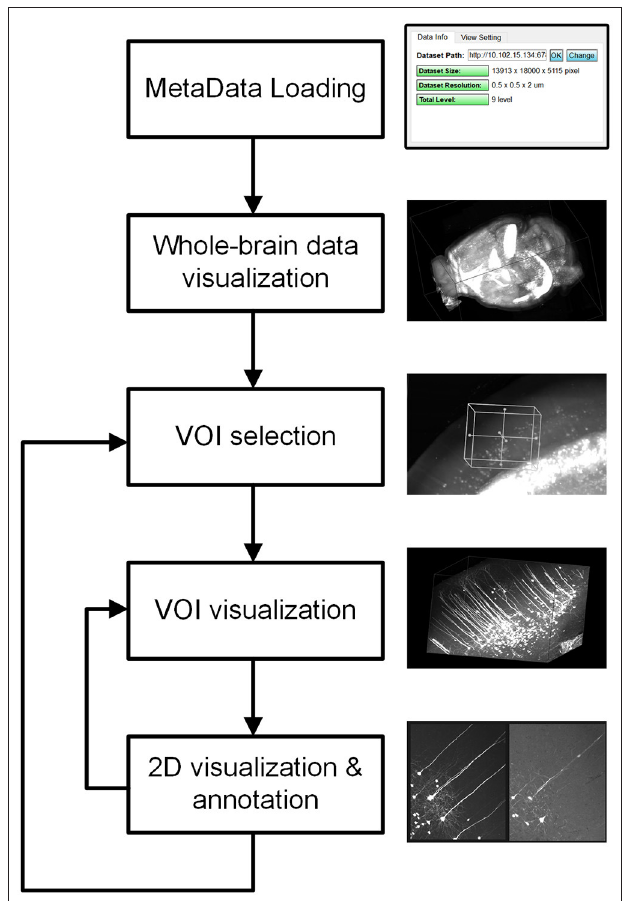
FIGURE 4 | Interaction style workflow of webTDat. The entire dataset can be browsed by continuously selecting VOIs. The VOIs are set in 3D and annotated in 2D. VOIs and their annotated results can be visualized in 3D or